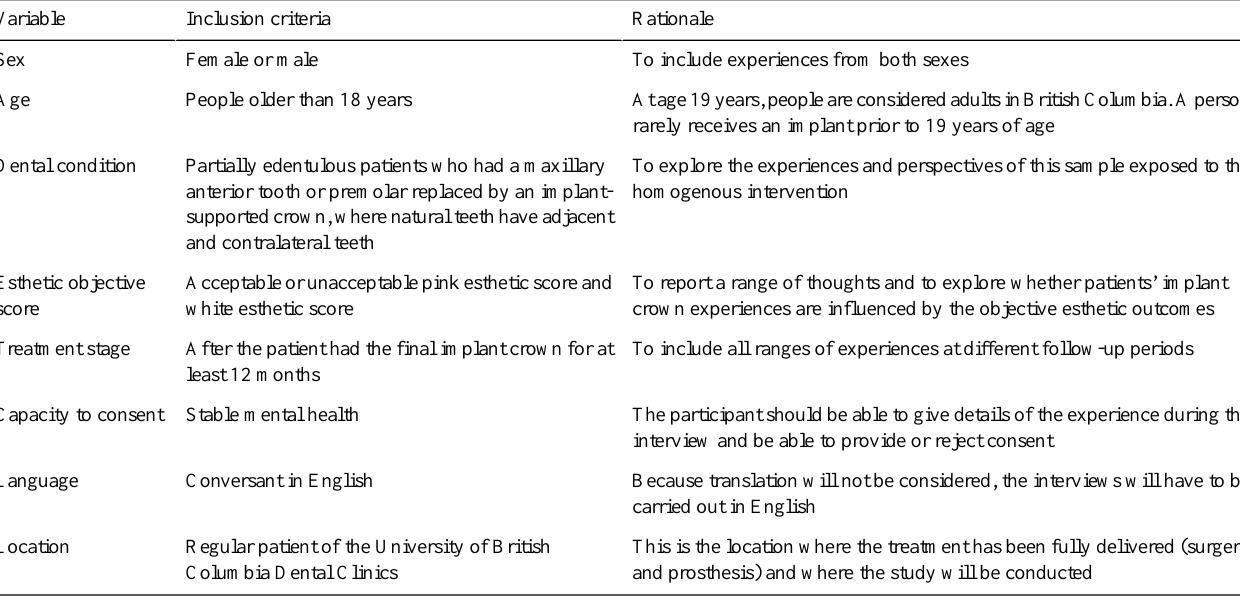
Table 1. Purposive sampling for the study: participant characteristics. RationaleInclusion